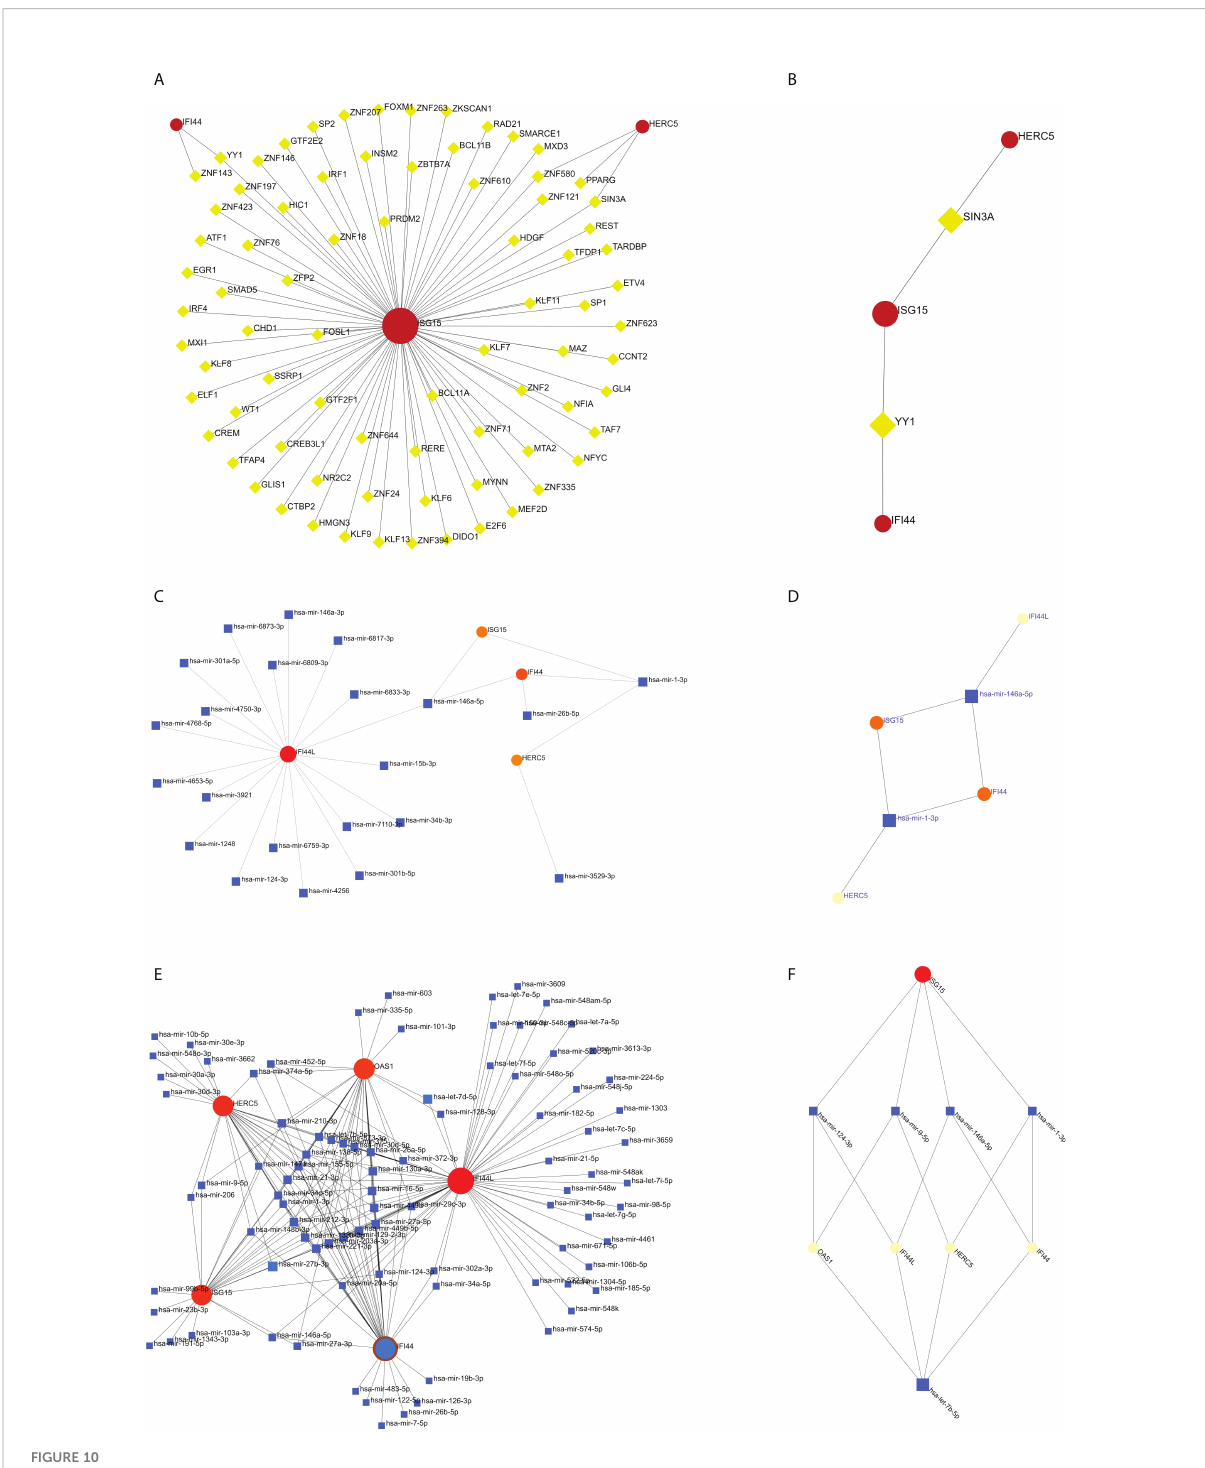
FIGURE 10 Construction of TF-hub gene and miRNA-hub gene network using NetworkAnalyst. (A, B) TF-hub gene network and simpli fi ed diagram. Red circles are genes, and yellow squares are TF. (C, D) miRNA-hub gene network (miRTarBase v8.0) and simpli fi ed diagram. (E, F) miRNA-hub gene network (TarBase v8.0) and simpli fi ed diagram. Circles are genes, and squares are